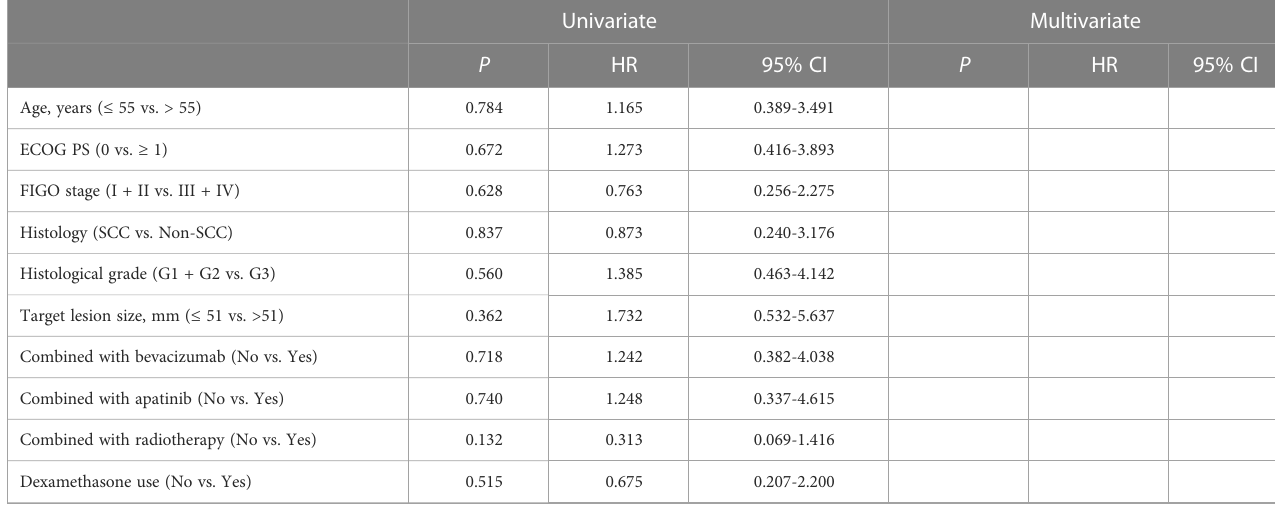
TABLE 7 Univariate and multivariate analyses of